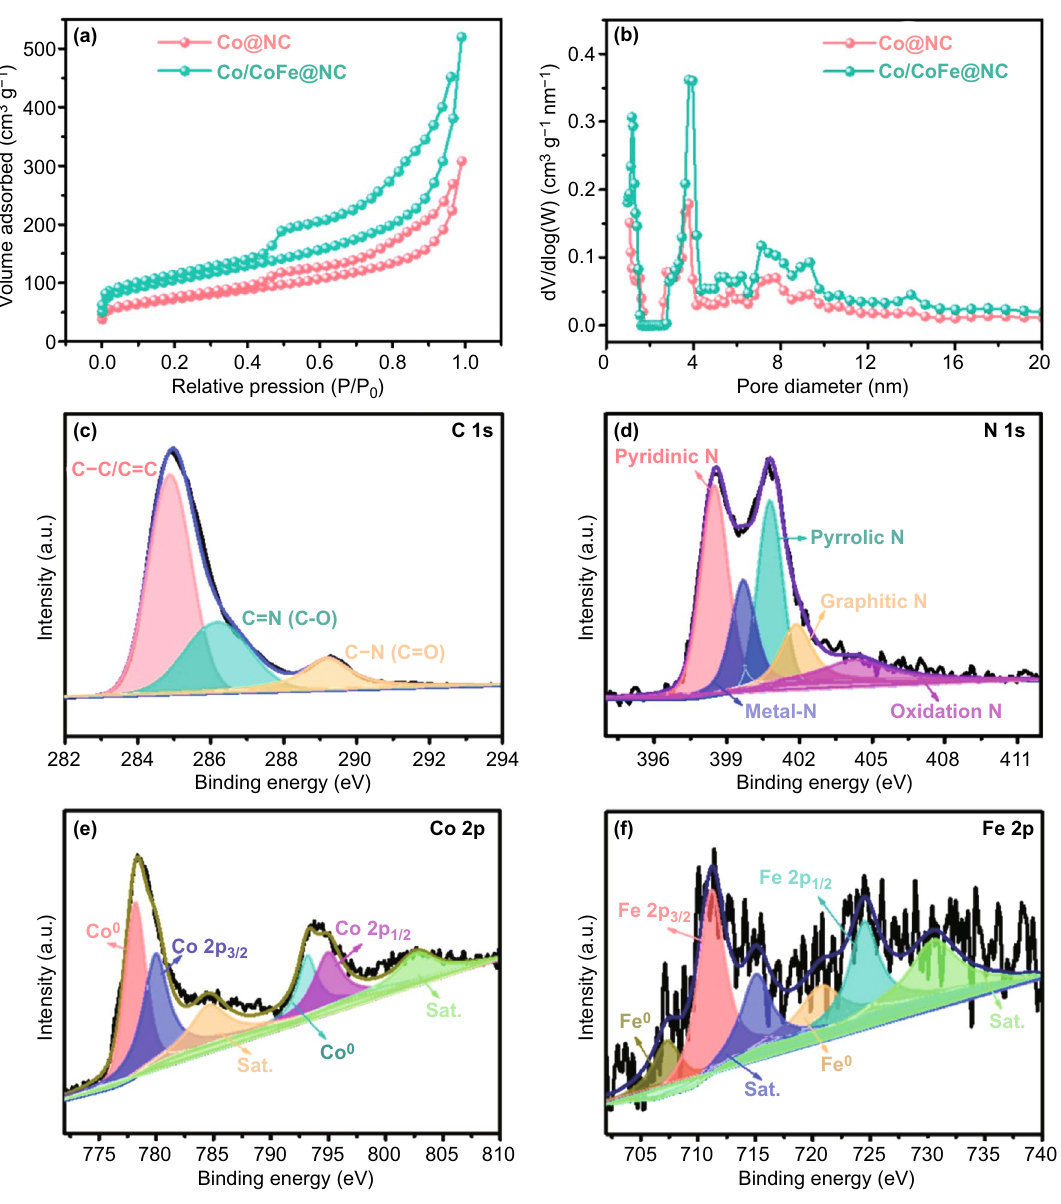
Fig. 3 a Nitrogen adsorption–desorption isotherms, and b pore size distribution of Co@NC and Co/CoFe@NC. High‑resolution XPS spectra of c C 1 s , d N 1 s , e Co 2 p and f Fe 2 p of